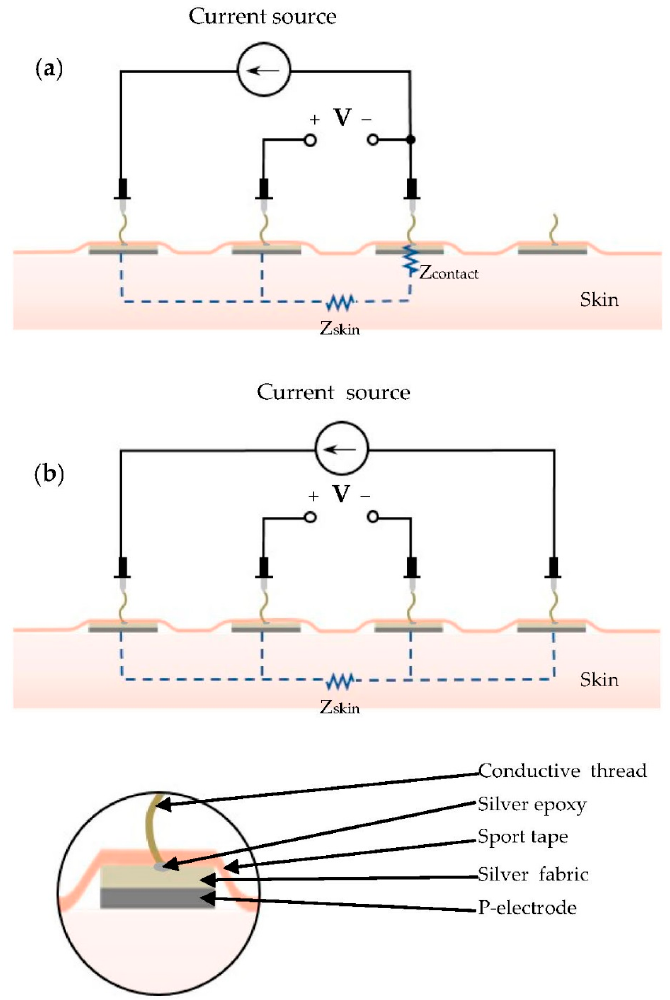
Figure 3. Experimental setup used to measure contact impedance. ( a ) Three-point probe configuration; and ( b ) four-point probe